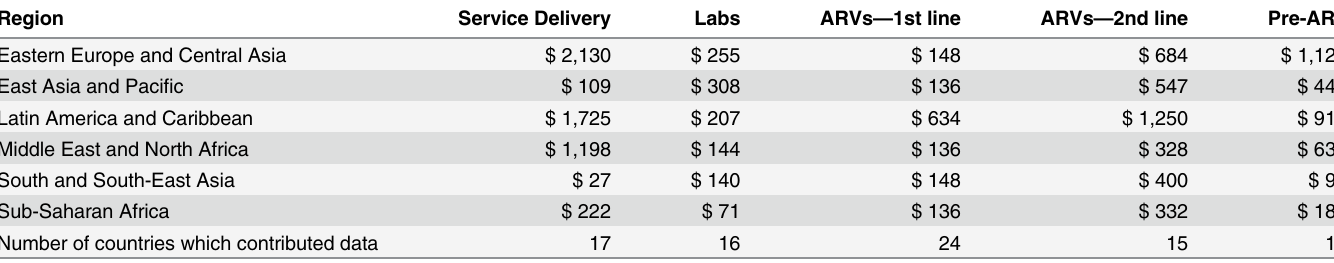
Table 3. Current cost per patient per year for ART and pre-ART services. (2015